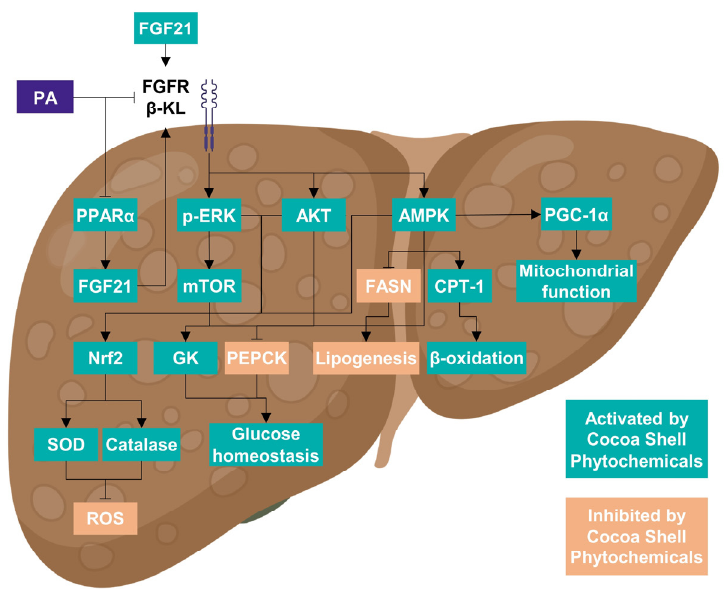
Figure 9. Illustrative diagram of the main events occurring in hepatocytes under non-alcoholic fatty liver disease (NALFD) conditions. The activation of FGF21 signaling by the phytochemicals from the cocoa shell is conducive to the regulation of lipid and glucose metabolism, via ERK, mTOR, AKT, and AMPK pathways. Harmoniously, these metabolic events lead to antioxidant enzymes stimulation and ROS reduction, and to the enhancement of mitochondrial bioenergetic functions. The blockade on liver metabolism generated by saturated fatty acids, here palmitic acid, is repressed, avoiding the development of NAFLD.